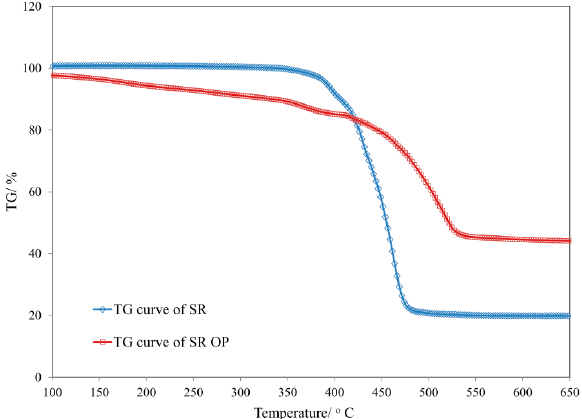
Figure 3. TG curves of uncured (SR) and cured (SR OP) silicone rubber.